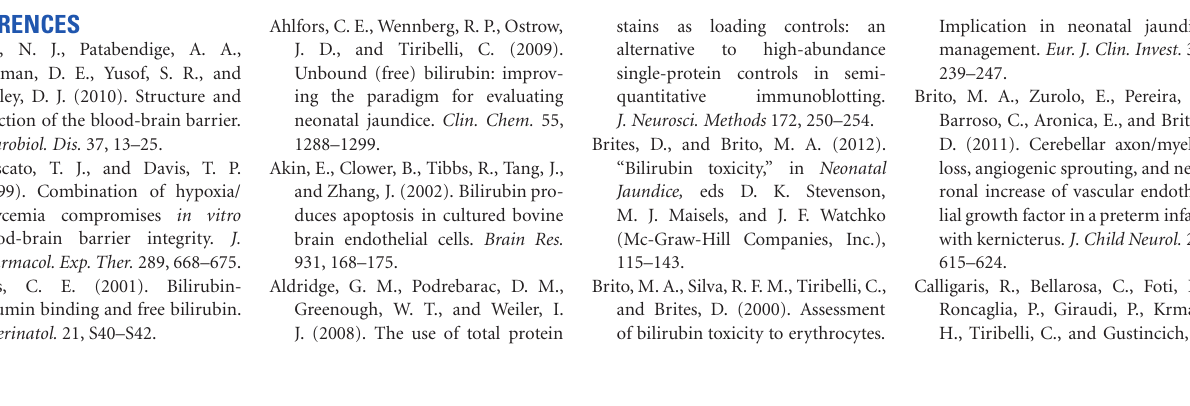
monolayer. This later response includes the disruption of the endothelial junctions, deficient cell-to-cell contacts and consequent detachment of cells, culminating in the passage of free UCB across the HBMEC